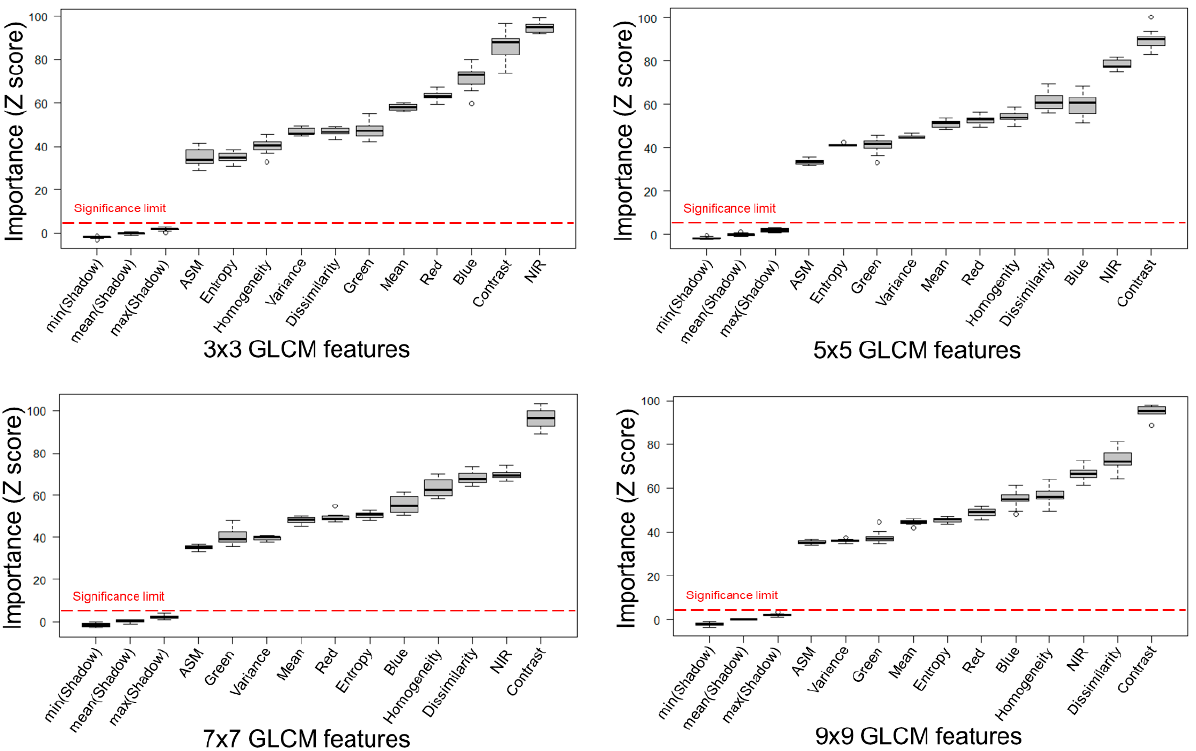
Figure 8. Feature importance ranking of each model. The red line indicates the limit of significance in the Boruta test.